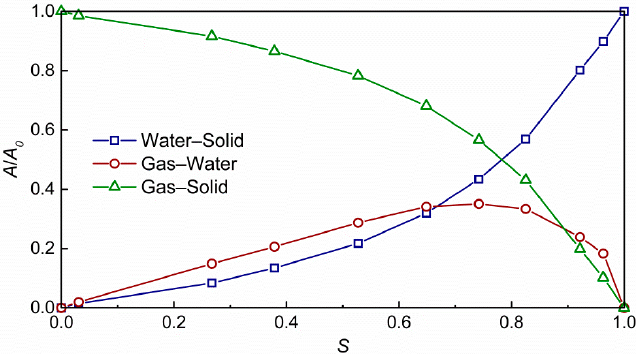
Figure 7. Changes of interface areas A / A 0 for water–solid, gas–water and gas–solid with water saturation.